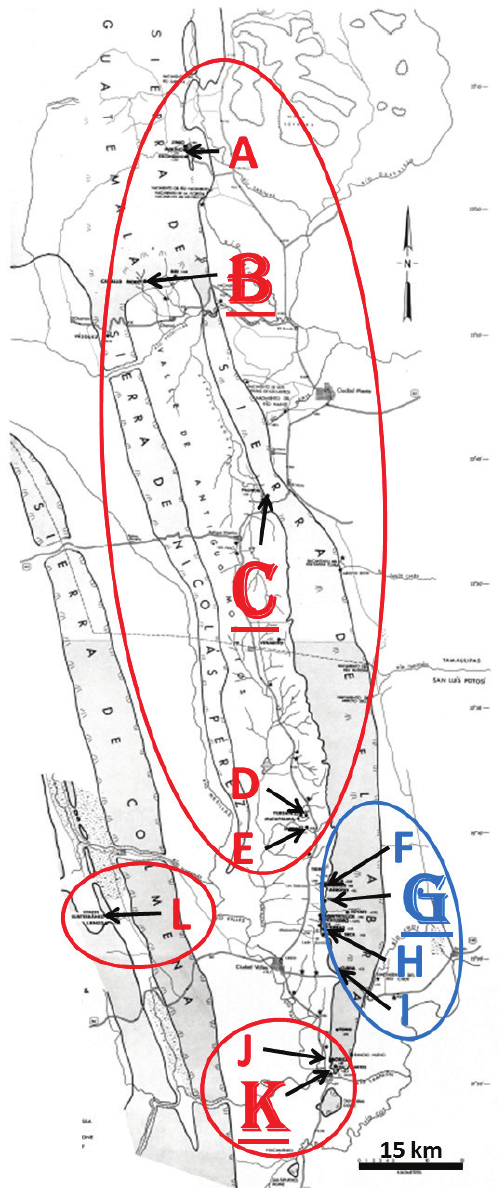
Figure 2. Cave localities of A. mexicanus whose mitochondrial DNA has been analyzed. With larger font and underlined are localities where S. quinterensis were also collected. In red are caves harboring lineage A and in blue those with lineage B for both mtDNA in Astyanax and histone 3 for S. quinterensis . Notice that lineage B is restricted to a small biogeographical zone, circled in blue. A Molino B Caballo Moro terraneo. (Figure modified from Mitchell et al.